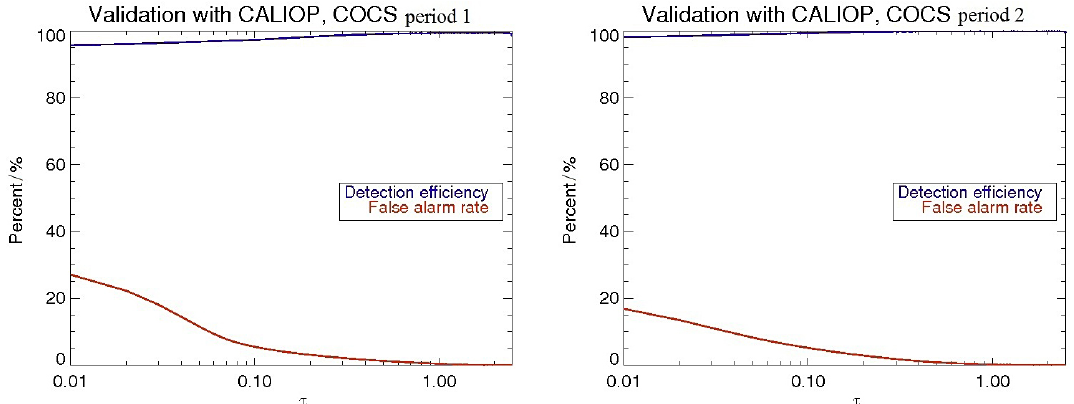
Figure 9. Detection efficiency eff det (blue) and false alarm rate (red) for COCS compared with CALIOP. COCS period 1 (left) and COCS period 2 (right).